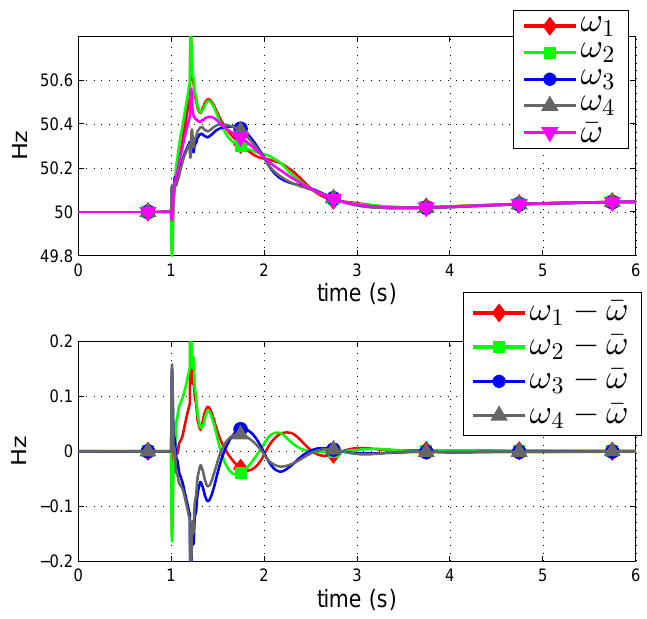
Figure 9. Frequencies measured at the converter stations ( ω i ) and WAF ( ¯ ω ) (when using P-WAF).